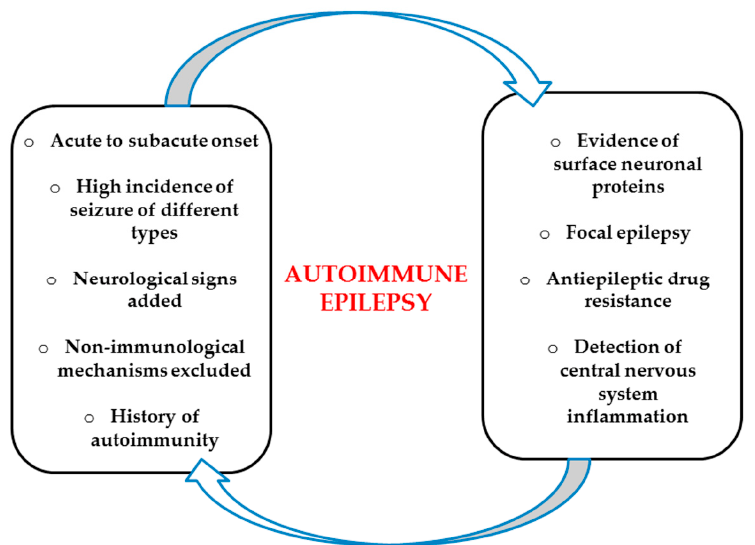
Figure 2. Clinical factors and features in the diagnosis of autoimmune epilepsy syndromes. In